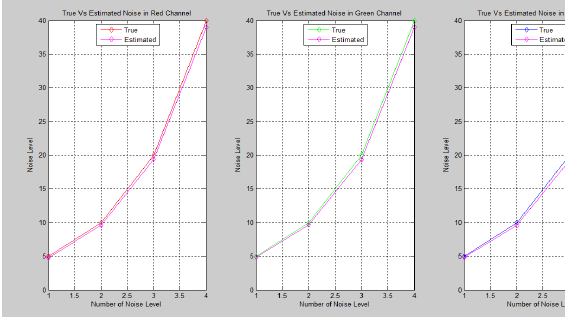
Figure 16. Noise Estimate for Test Images The proportion of the maximum signal with corrupted noise which affects the normal peak signal to noise proportion is